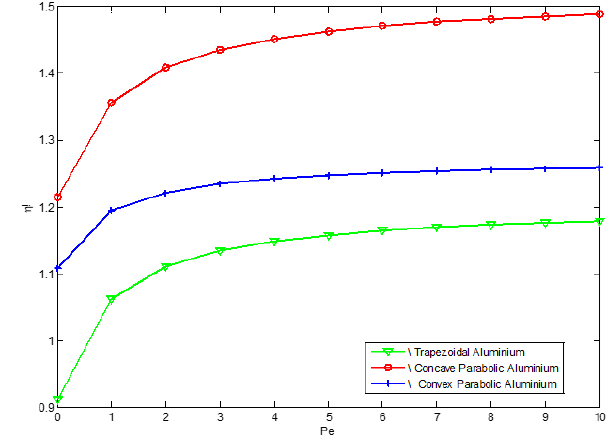
Figure 18. Variation in volume adjusted efficiency with peclect number for Aluminium porous fins